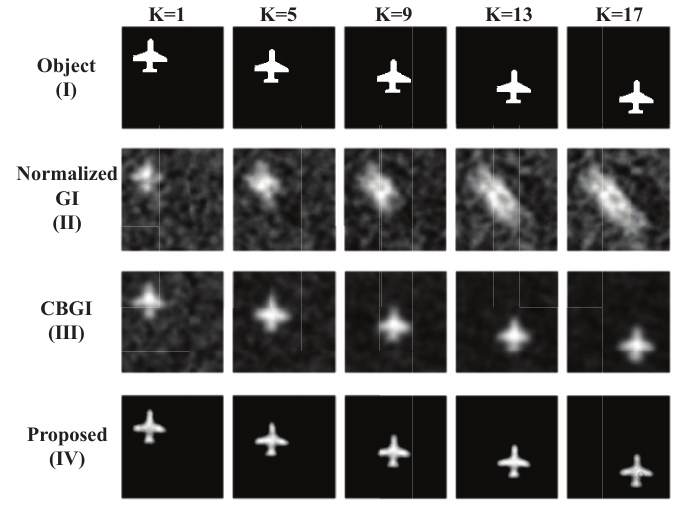
Figure 2. Reconstructed images of ( I ) the ideal moving object, ( II ) normalized GI, ( III ) CBGI, ( IV ) CS with the centroid estimation, with the same image period m =